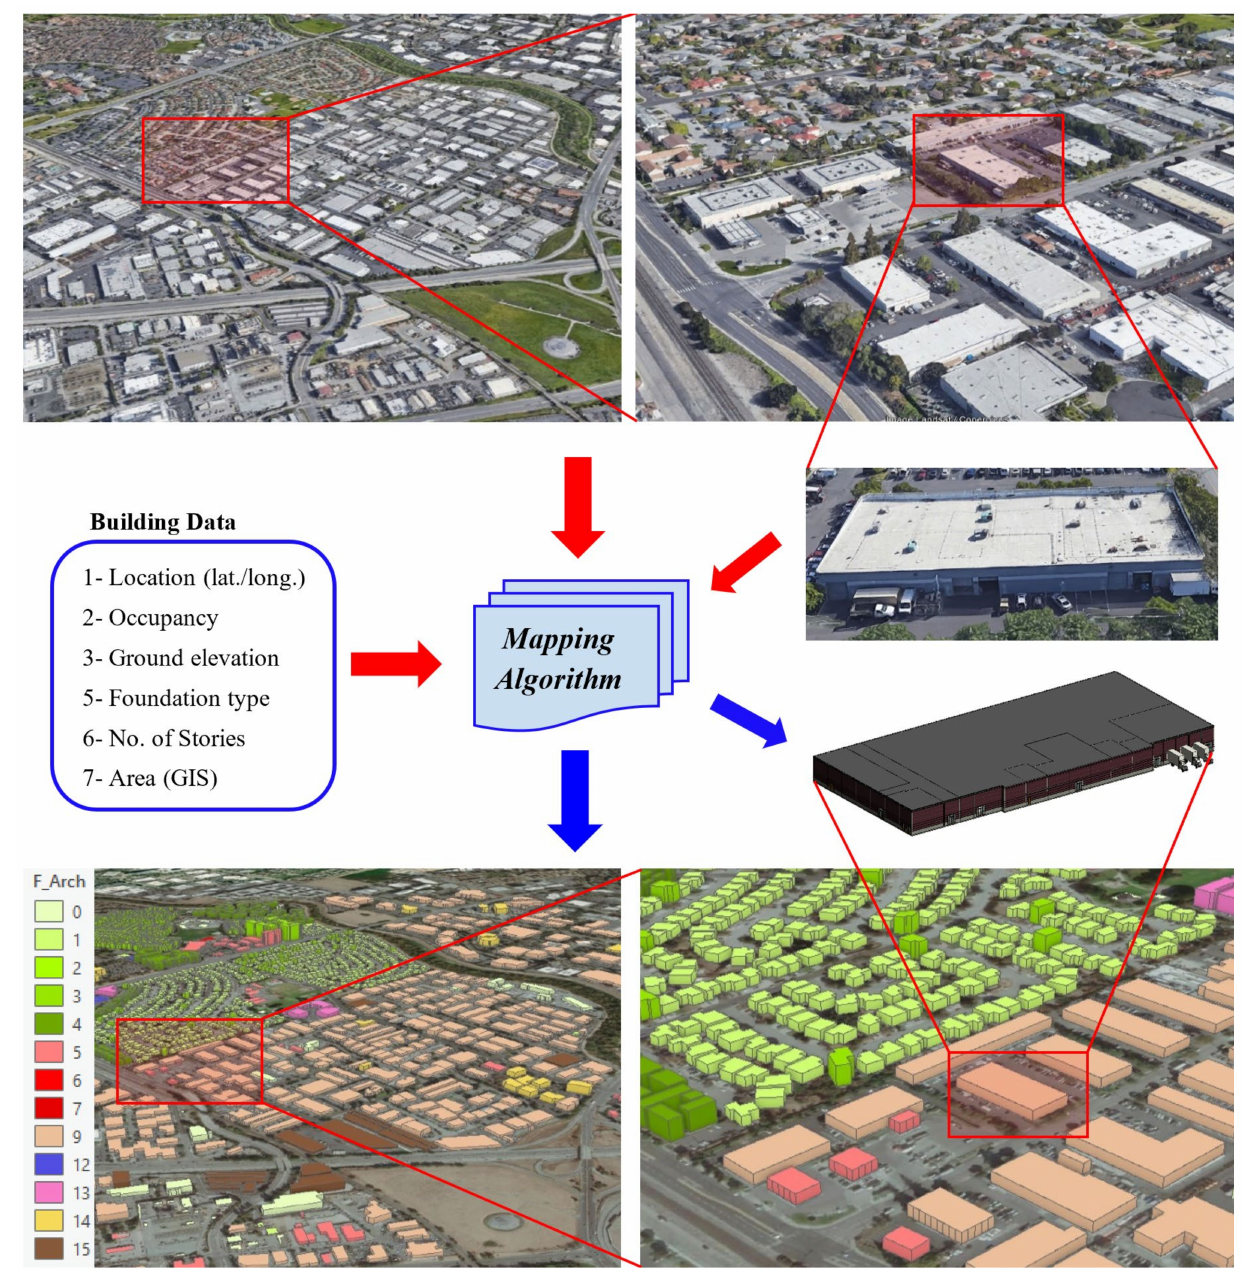
Figure 2. A schematic representation shows how a portfolio of building archetypes are mapped to buildings within a community based on detailed building